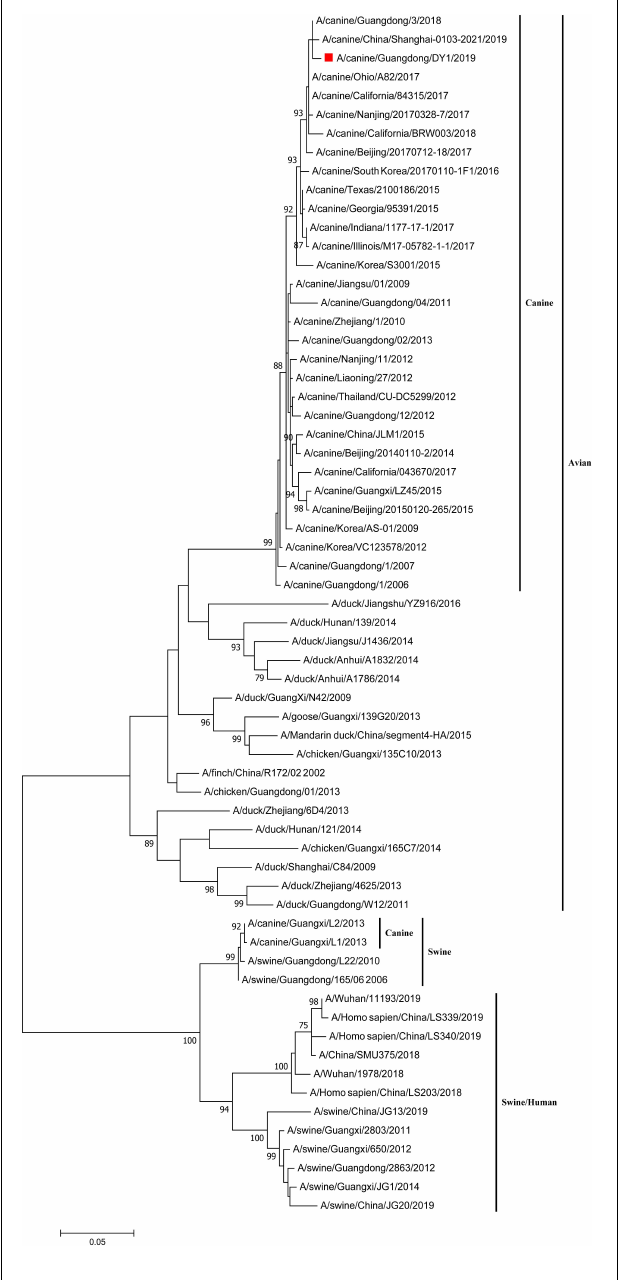
FIGURE 1 | Phylogenetic analysis of HA gene of CADY1/2019. Phylogenetic trees for whole gene segments of CADY1/2019 created with 1000 bootstrap replicates using MEGA 7.0 software. Solid red square indicated CADY1/2019 in each phylogenetic tree. Phylogenetic trees of HA genes based on nucleotides (nt)